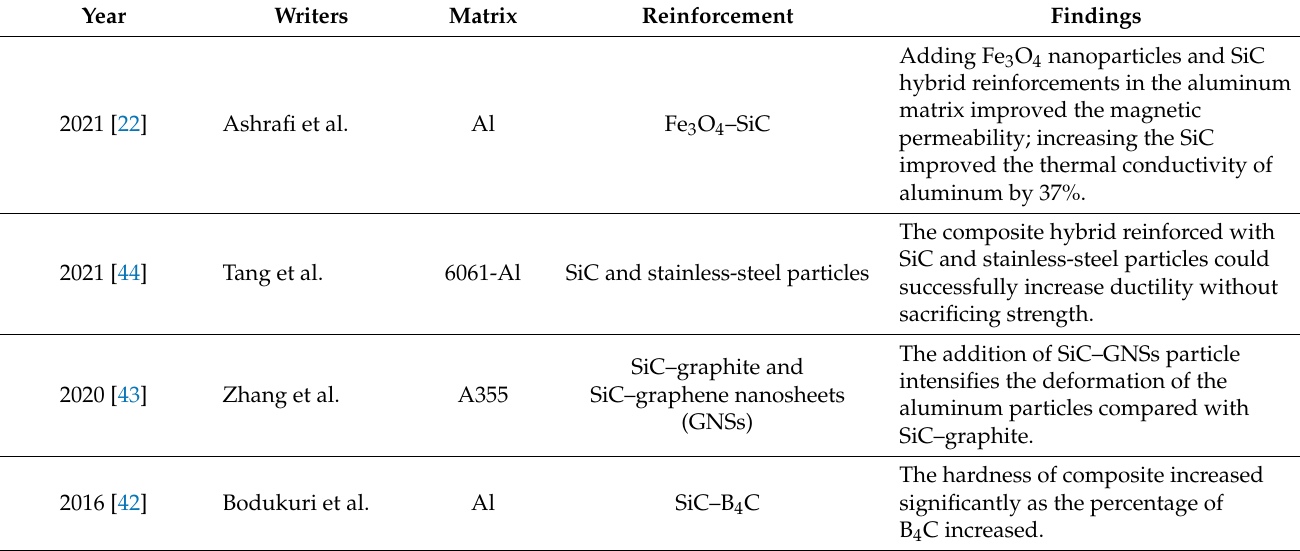
Table 3. Research articles about powder